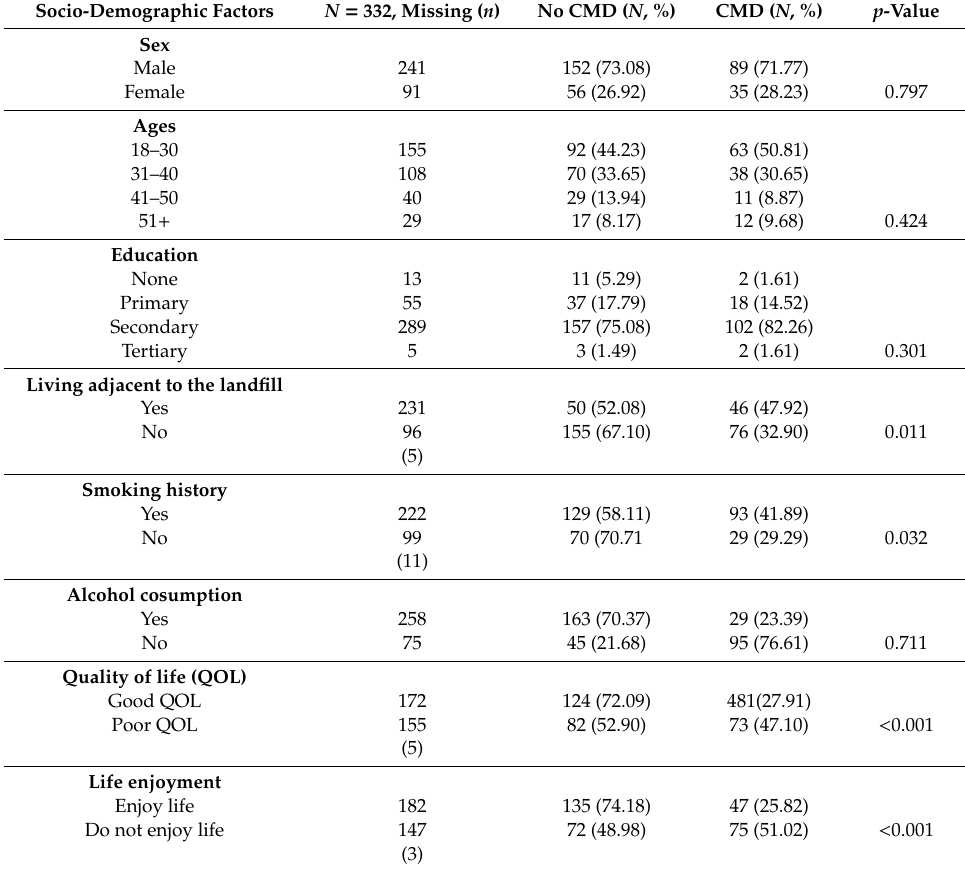
Table 2. Prevalence of CMD by socio-demographic factors among waste